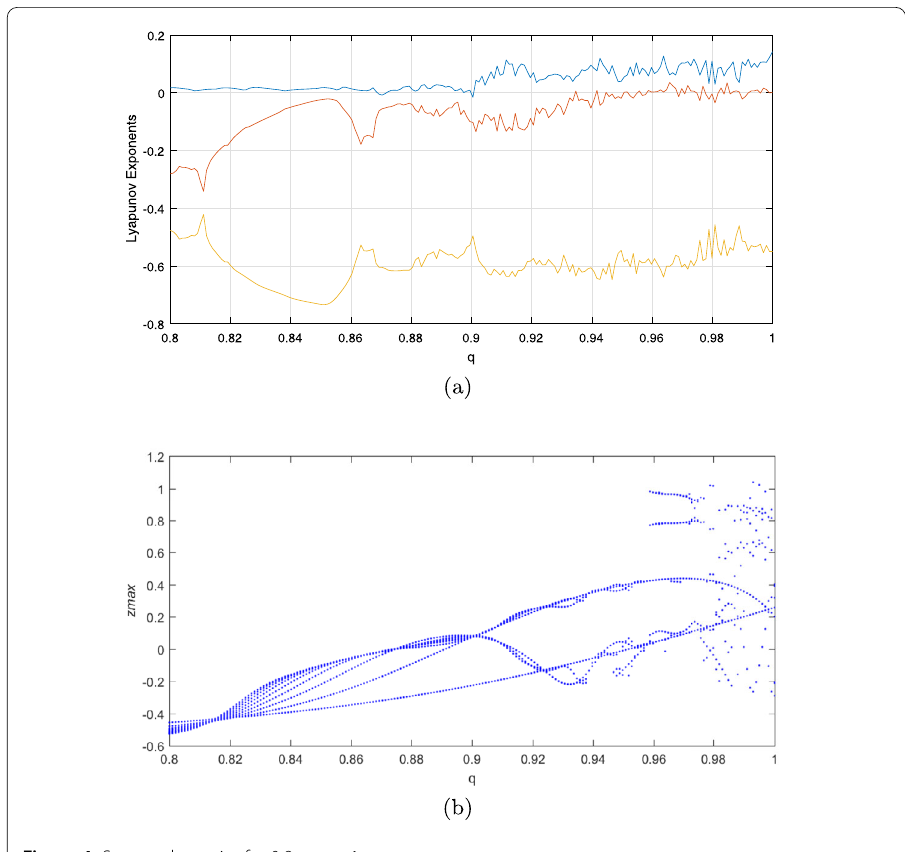
Figure 4 System dynamics for 0.8 ≤ q ≤